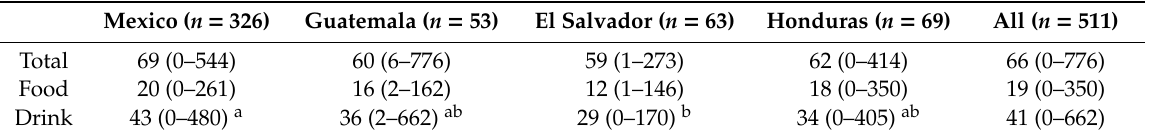
Table 2. Comparison of daily sugar intake (in g) by country of